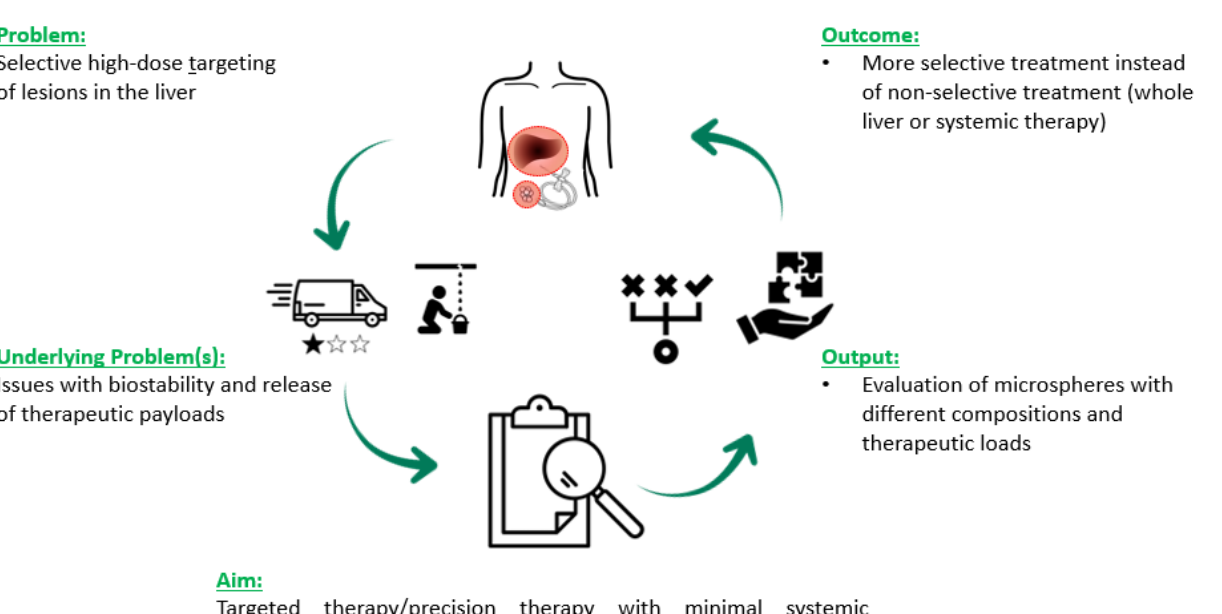
Scheme 1. Theory of change for improving therapeutic embolization procedures using